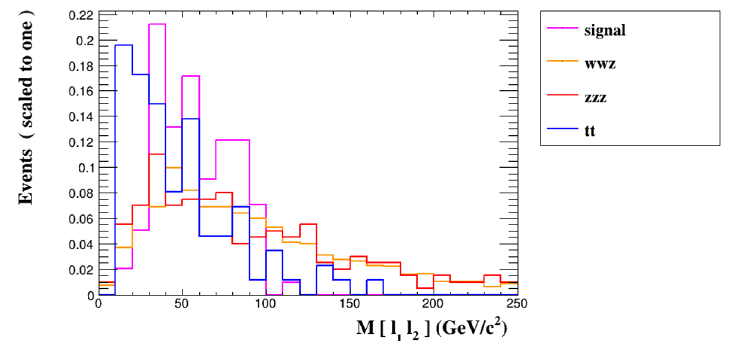
Figure 6 . The distribution of invariant mass of the leading two leptons, the different distributions are normalised to